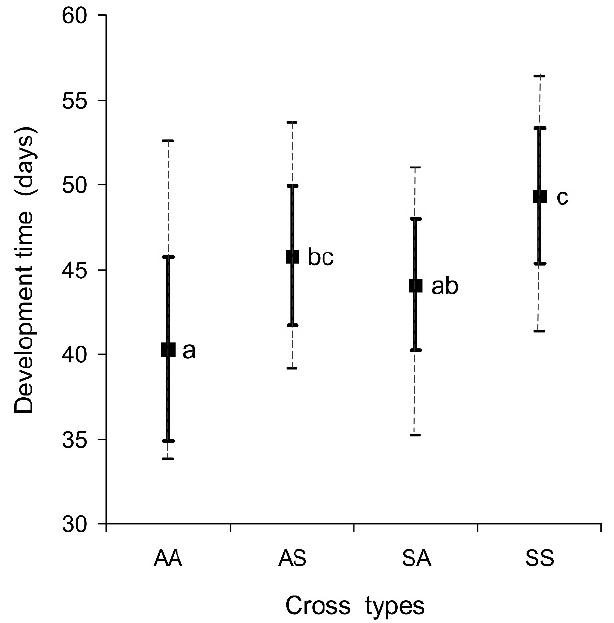
Figure 1. Pre-adult development time of the progeny of four Halyomorpha halys cross types. The cross types are indicated by the initials of population origin of female and male: A—Andong, S—Sochi. Means, SD (solid bold lines), and ranges (broken lines) for the mean values separately calculated for each parent pair of each cross type ( n = 13–20) are presented. Symbols with different letters correspond to significantly different means ( p < 0.05 by the Tukey’s HSD test). Progeny of all pairs of all cross types developed under the same conditions (25 ◦ C, L:D 15:9